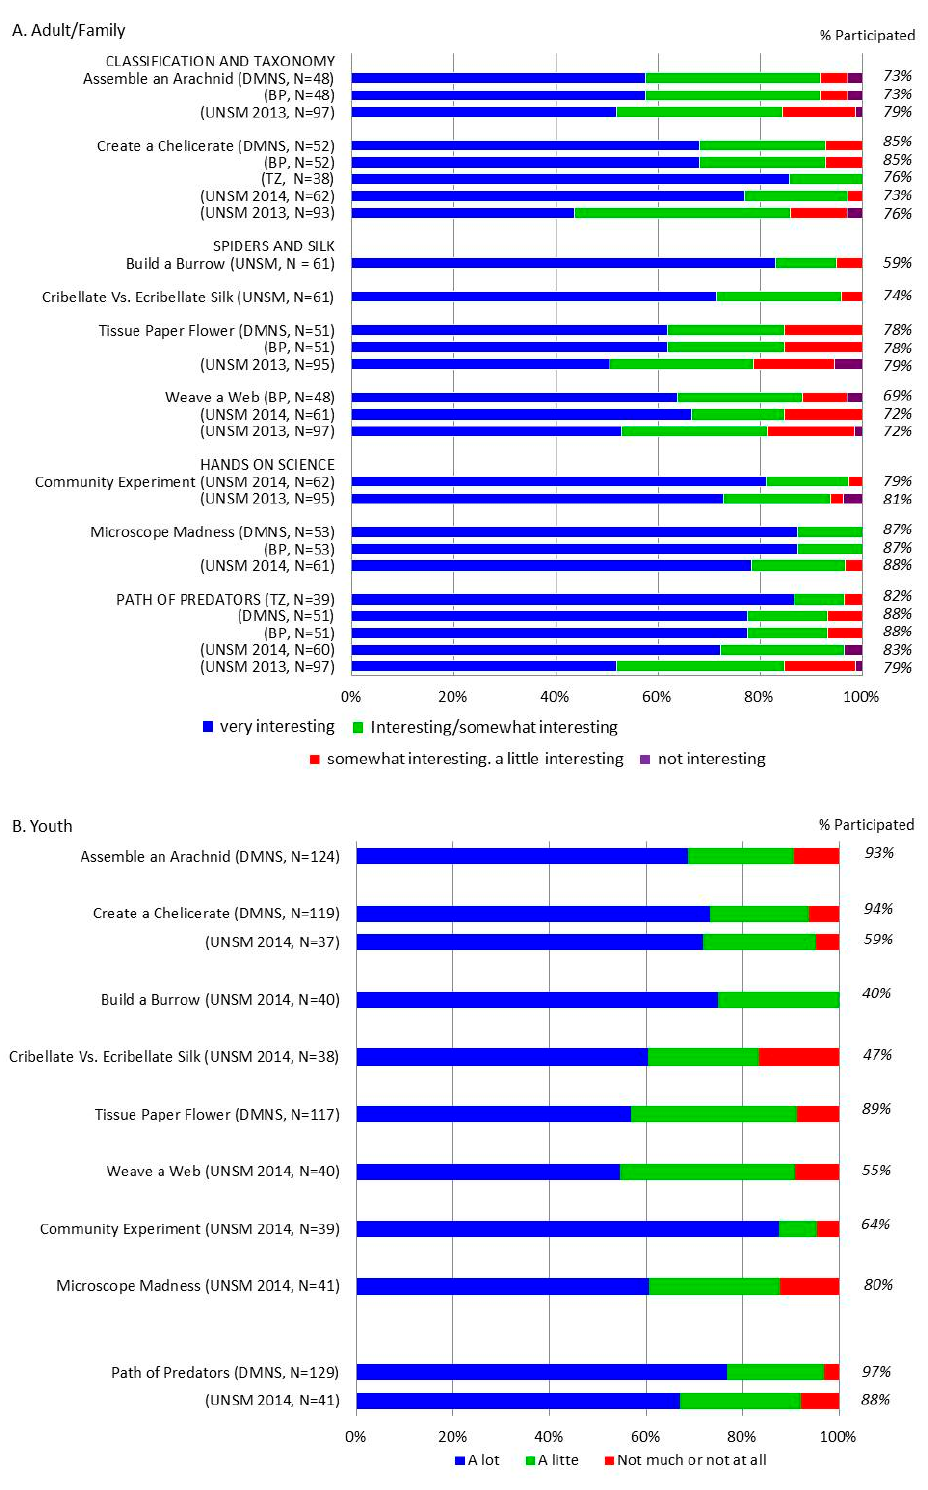
Figure 5. The majority of adults/families ( A ) participated in the surveyed stations, and the majority found them to be “very interesting” or “interesting/somewhat interesting”. The youth ( B ) reported lower participation at some surveyed stations (e.g., Cribellate vs. Ecribellate Silk and Build a Burrow) but similar to adults, the majority of surveyed youth found the activities to be “a lot” or “a little” interesting. Across both groups, there was only a small number of participants reporting “not interesting” (4% in adults; 10% in youth).